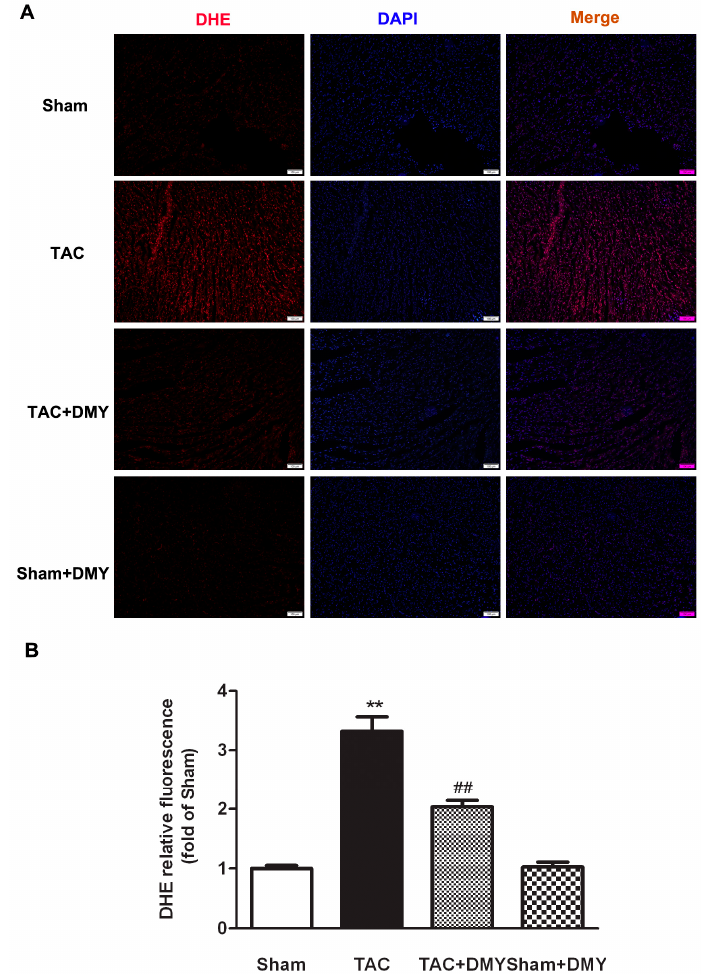
Figure 6. Effect of DMY on oxidative stress in the myocardium of mice after TAC. ( A ) Representative images of dihydroethidium (DHE) staining (Red) of the myocardium were shown. The nuclei were counter-stained with 4’,6-diamidino-2-phenylindole, dihydrochloride (DAPI) (Blue). Bar = 100 µ m (Figure 6A). ( B ) Quantification of DHE fluorescence intensity was shown. ** p < 0.01 versus Sham, ## p < 0.01 versus TAC ( n = 8).